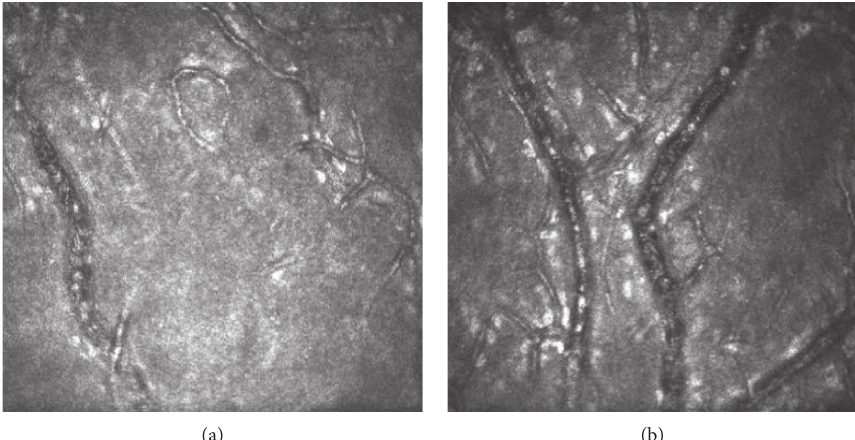
Figure 6: Analysis of corneal vascularisation in moderate (a) and advanced (b) conjunctival ingrowth assessed with confocal microscopy